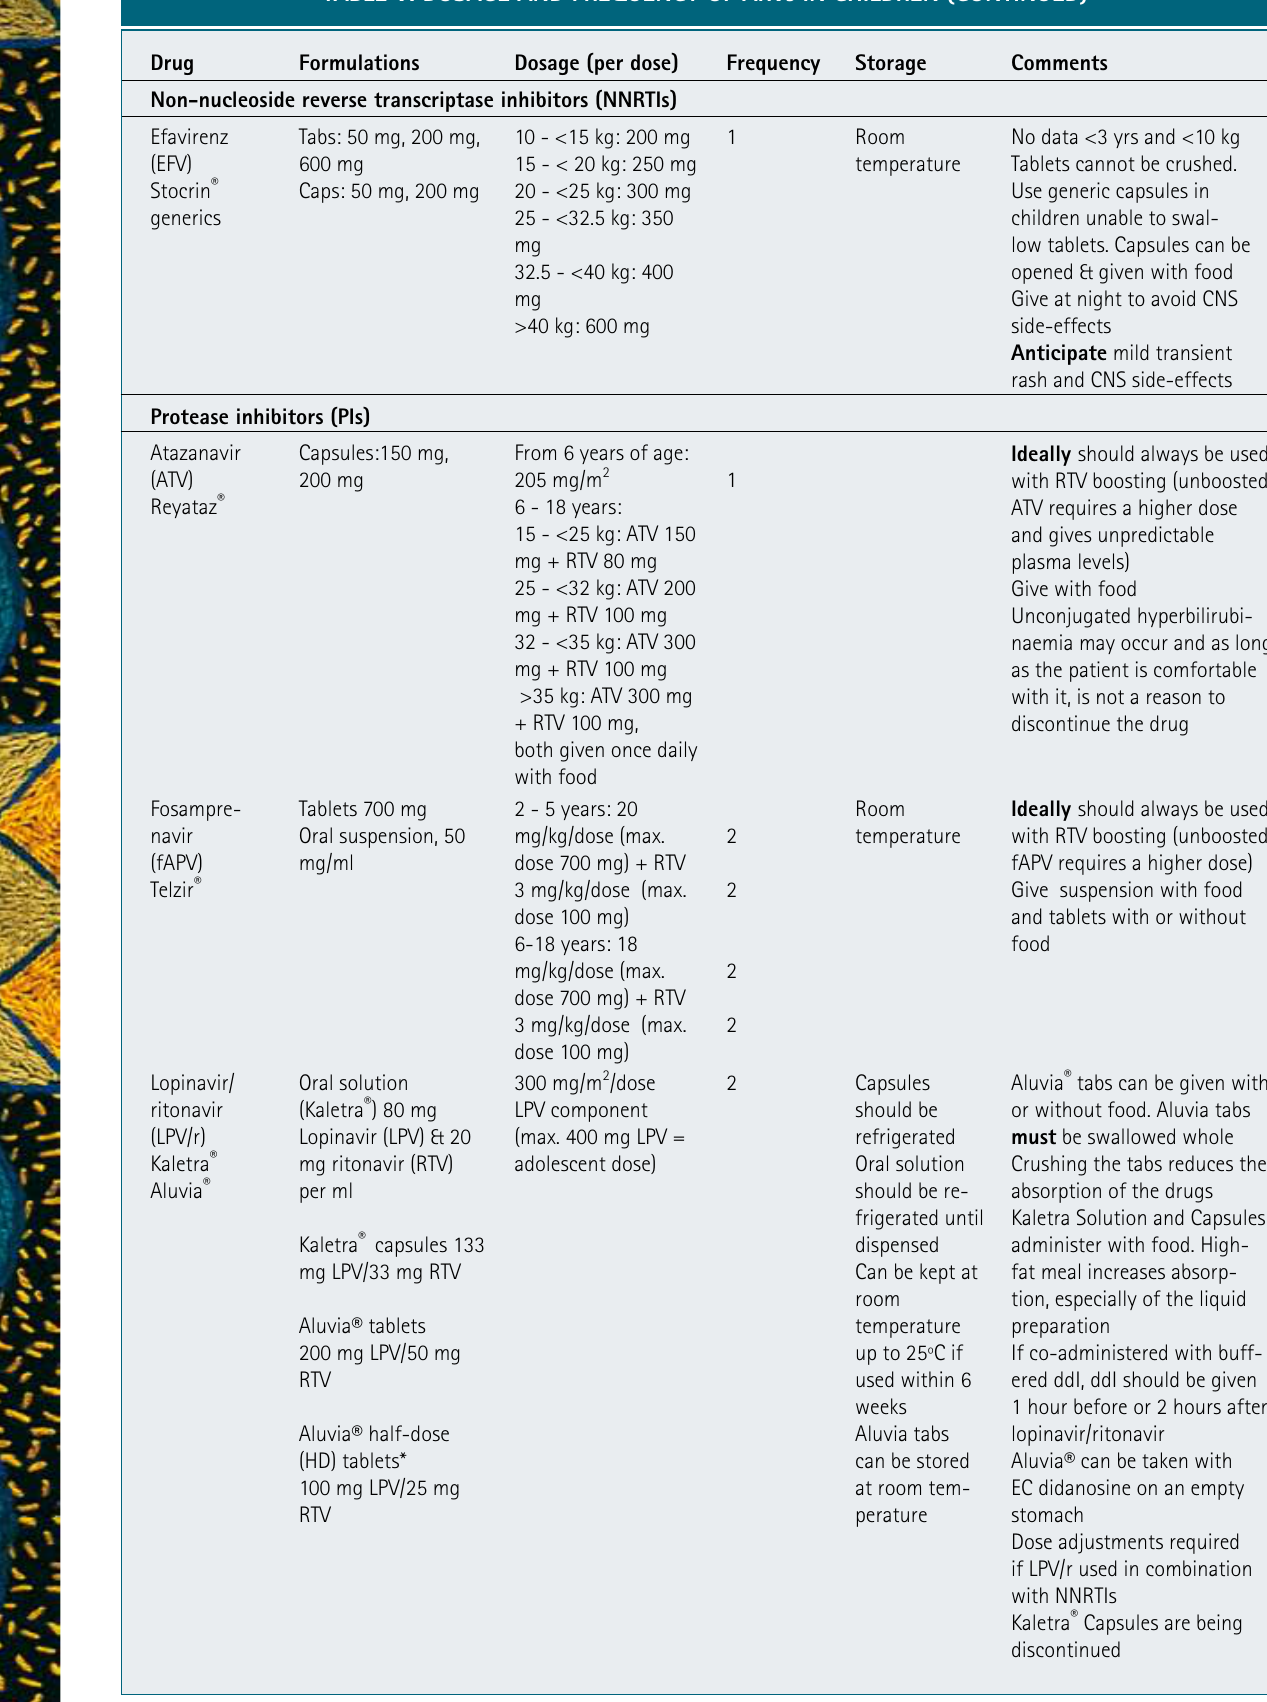
TABLE V. DOSAGE AND FREQUENCY OF ARVs IN CHILDREN